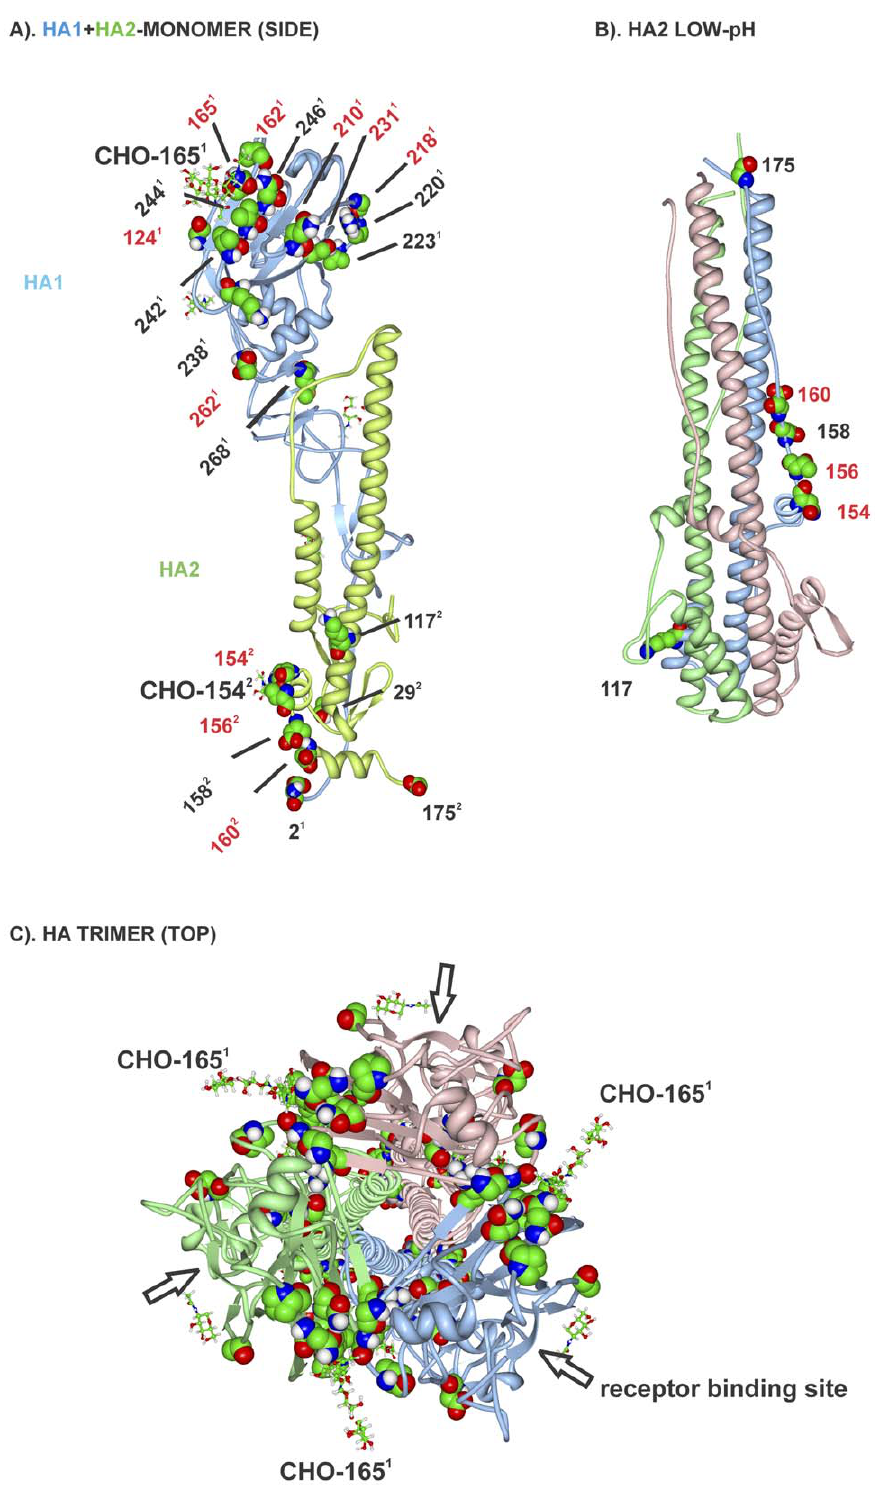
Figure 7. Mouse adaptive mutations in the crystal structure of the HA protein monomer, trimer and low-pH HA2 trimer. Mutations are shown as described in Fig. 3. (A) the side view of the HA monomer composed of HA1 and HA2 (indicated with superscripts 1 and 2) with carbohydrate side chains shown (CHO) in stick diagram is included here for reference (a similar but unglycosylated map that was generated from an independent sequence analysis has been published [10]); (B) the low pH form of HA2; and (C) the HA trimer, top view with receptor sites indicated with arrows.